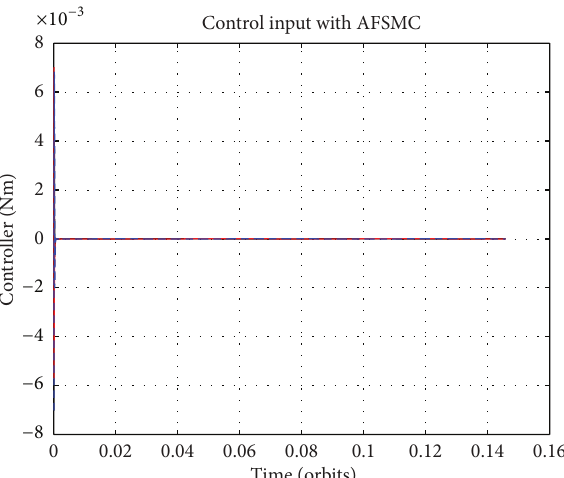
Figure 12: Scenario 5 nadir pointing control results using three wheels: control